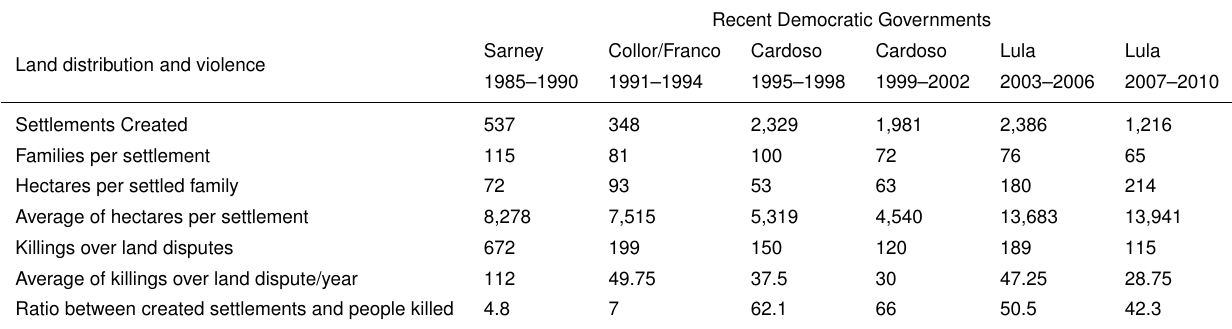
Table 3. Results in land distribution relating to agrarian violence in democratic